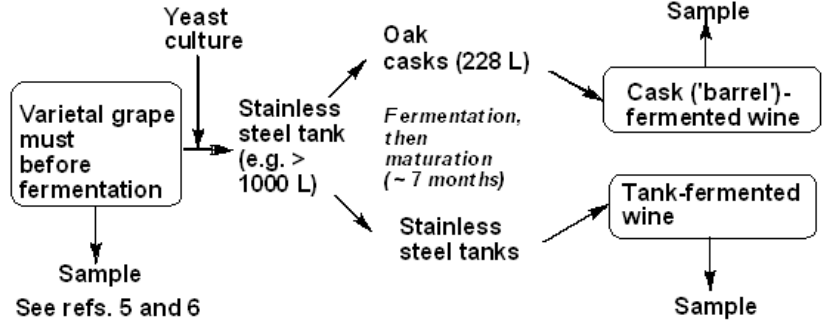
Figure 1. Sample origin and relationships. The full scheme applies to the musts and wines of the varietals Huxelrebe, Ortega and Schönburger. Tank wine only was produced from the must of Siegerrebe.